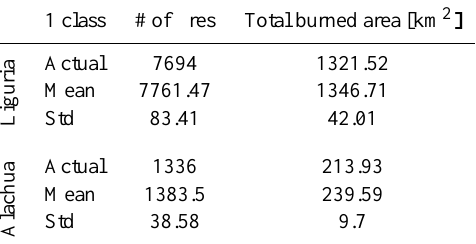
Table 4. Comparison between observed number of fires, total burned area and simulated distribution of the same parameters by using DS-FFM (1 class). The mean values and the standard de- viation of the number of fires and the total burned area obtained simulating 1000 different trials are reported for the 2 considered